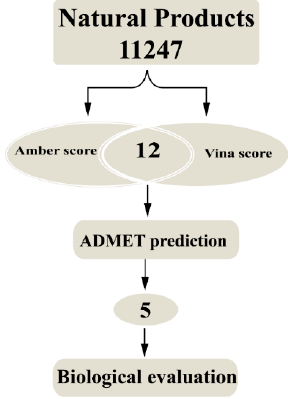
Figure 1. The brief workflow of identification of novel potential inhibitors targeting human epidermal growth factor receptor 2 (HER2).